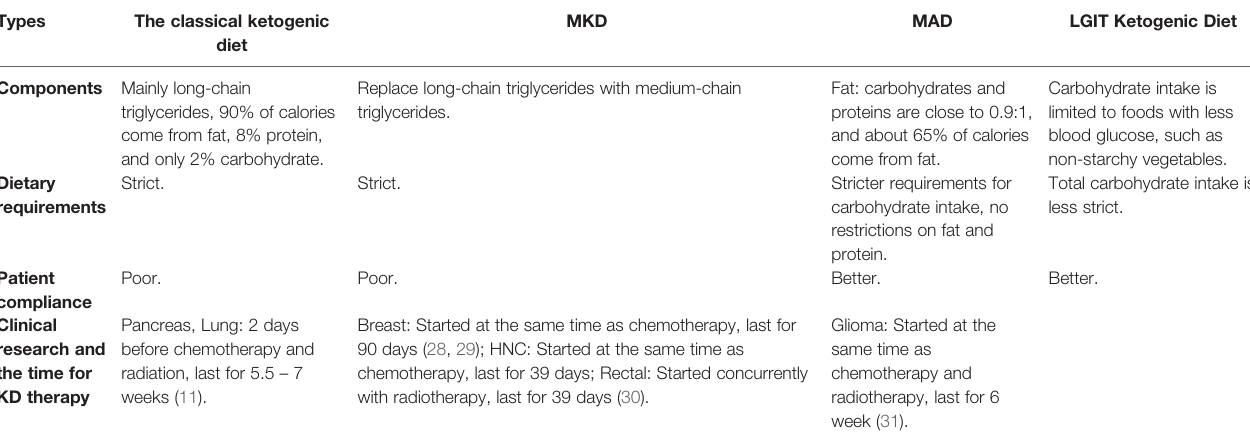
TABLE 1 | Types, characteristics and clinical research of ketogenic